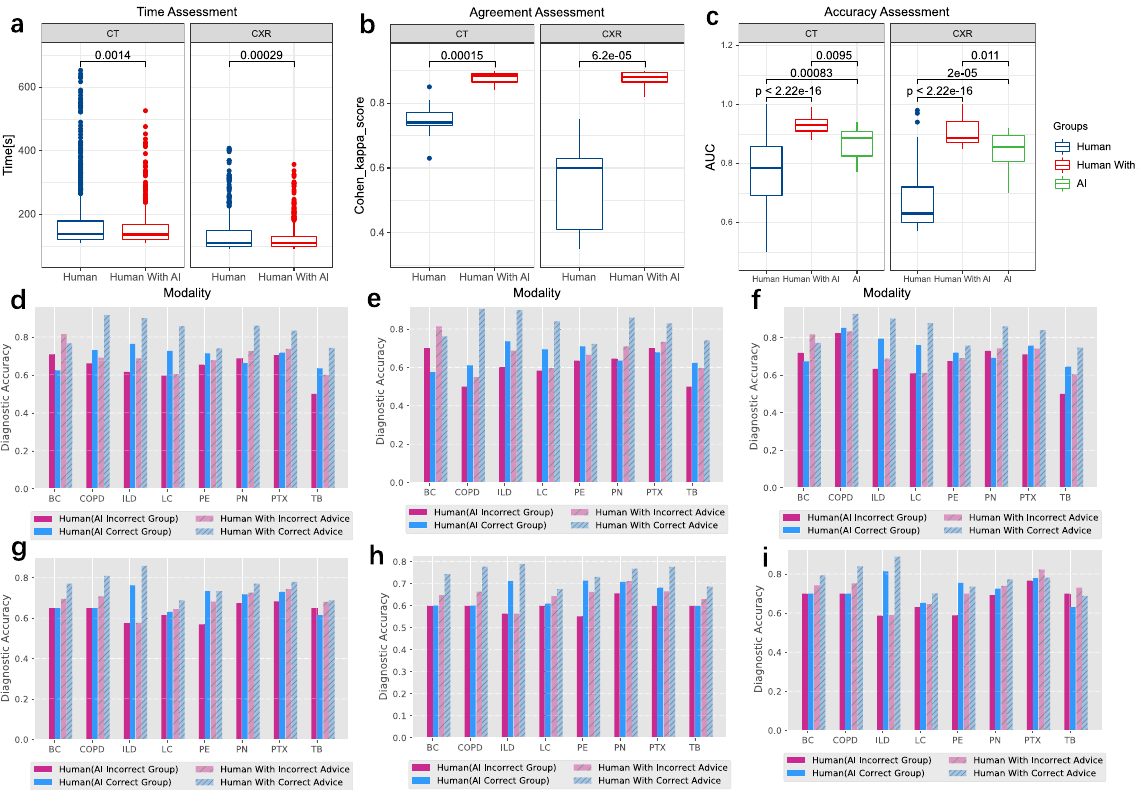
Fig. 5 Comparison of human-only, human with AI, and AI-only diagnoses for clinical radiation implementation. a Time assessment of diagnosis without and with the assistance of the deep learning system. b Agreement of eight experts in disease diagnosis without and with the assistance of the deep learning system c displays the performance of the AI approach (AI only), the current clinical work fl ow (human only), and the AI-assisted approach (human with AI). Each box represents the interquartile range (IQR, 25th and 75th percentiles) and the center line represents the median of the results. The whiskers represent minimum and maximum data points, excluding outliers. Outliers are de fi ned as greater than the 75th percentile + 1.5 × IQR and smaller than the 25th percentile − 1.5 × IQR and are denoted as nodes. d Mean diagnosis performance among a diverse range of human readers with correct/incorrect AI advice based on CT images. e , f Diagnosis performance of junior and senior readers with various AI advice based on CT images. g Mean diagnosis performance among a diverse range of human readers with correct/incorrect AI advice based on CXR images. h , i Diagnosis performance of junior and senior readers with various AI advice based on CXR images. BC bronchiectasis, COPD chronic obstructive pulmonary disease, ILD interstitial lung disease, LC lung cancer, PE pleural effusion, PN pneumonia, PTX pneumothorax, TB